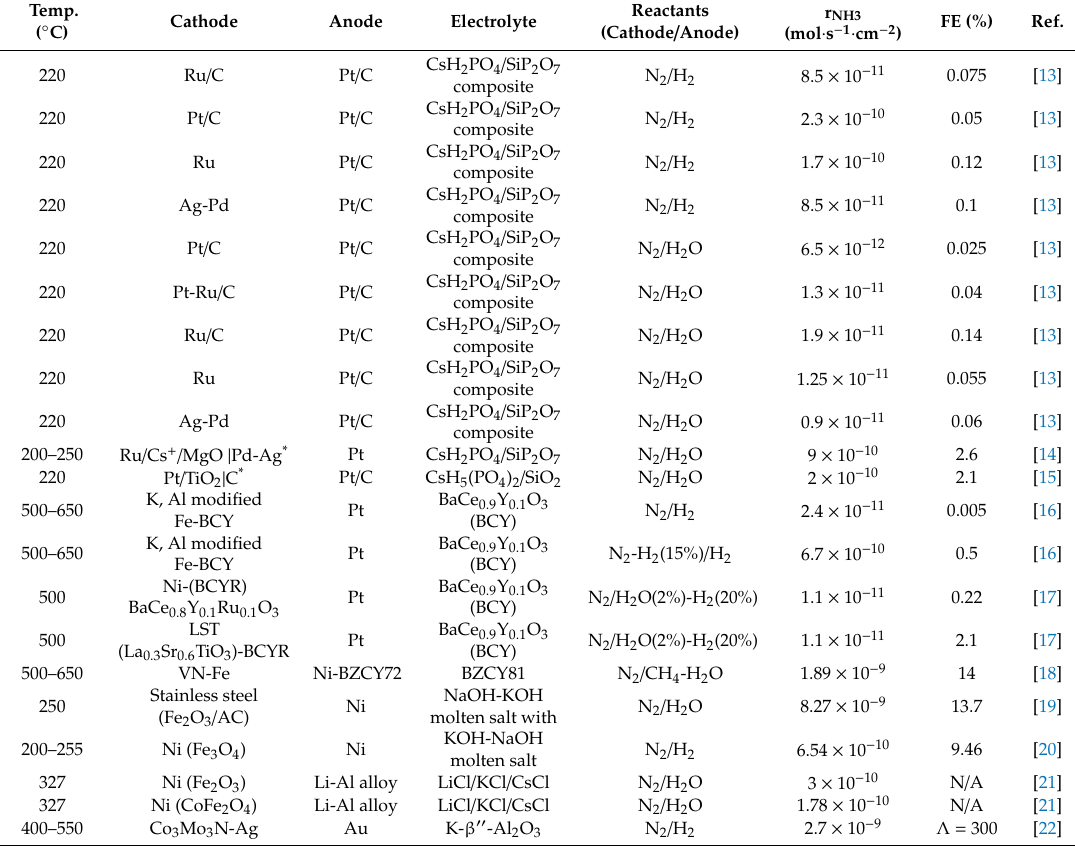
Table 1. Studies at high